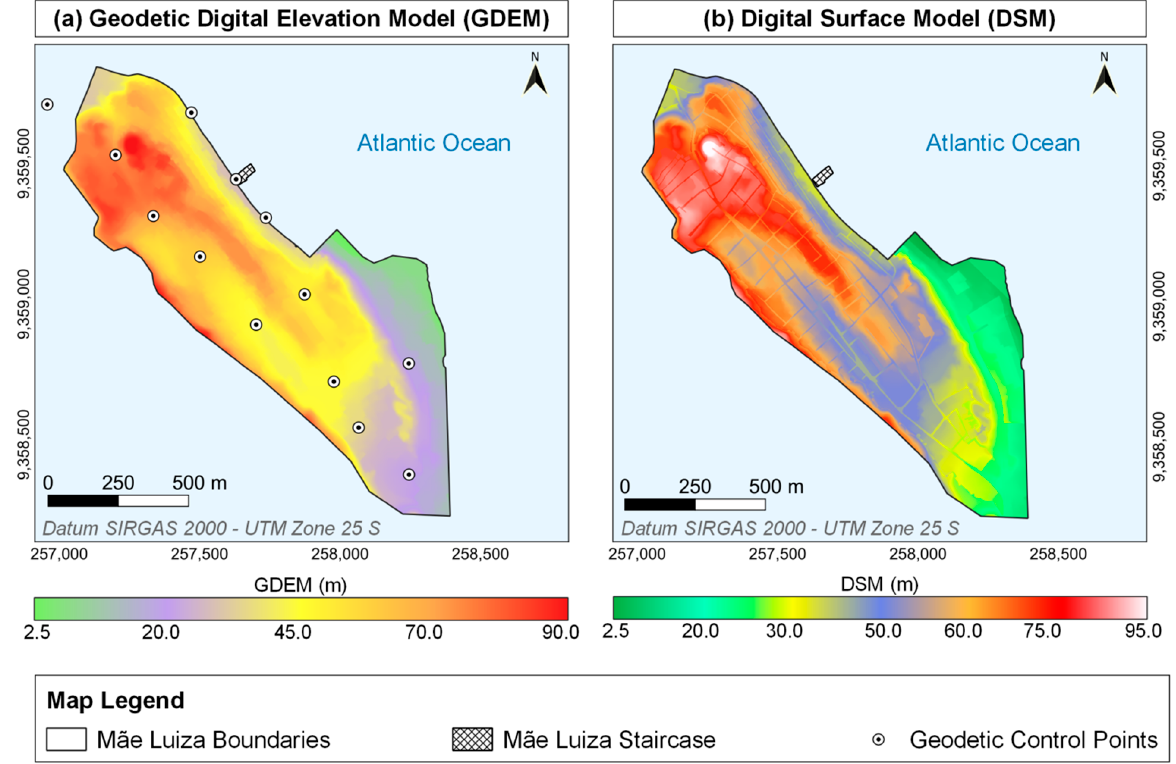
Figure 8. Digital Terrain Model with geodetic calibration ( a ) and Digital Surface Model ( b ) for the district of Mãe Luiza, Natal, Rio Grande do Norte.